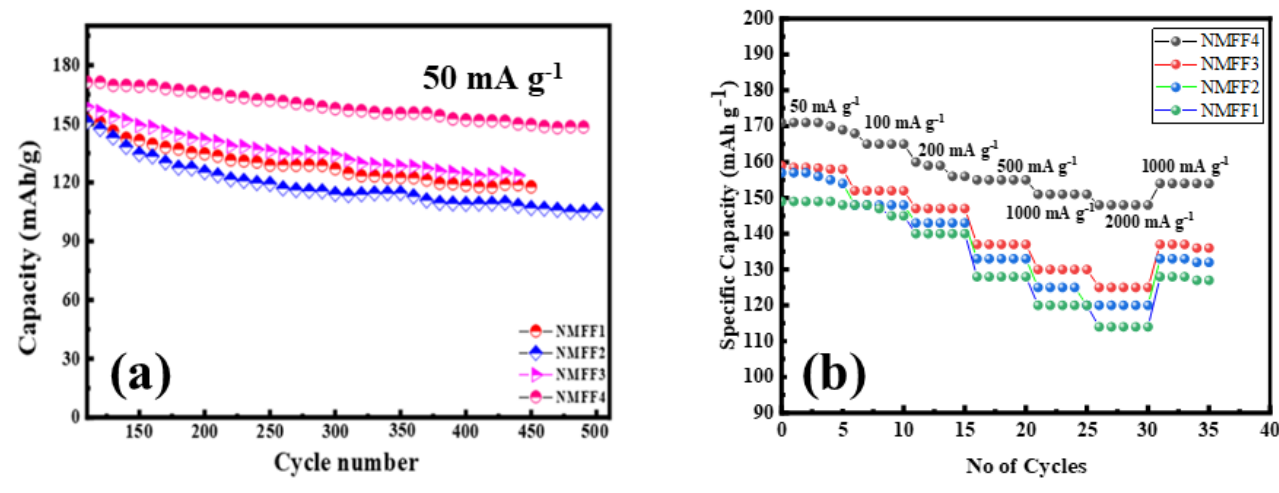
Figure 8. ( a ) Cyclic performance of NMFF1, NMFF2, NMFF3, and NMFF4; and ( b ) rate performance of NMFF1, NMFF2, NMFF3, and NMFF4.